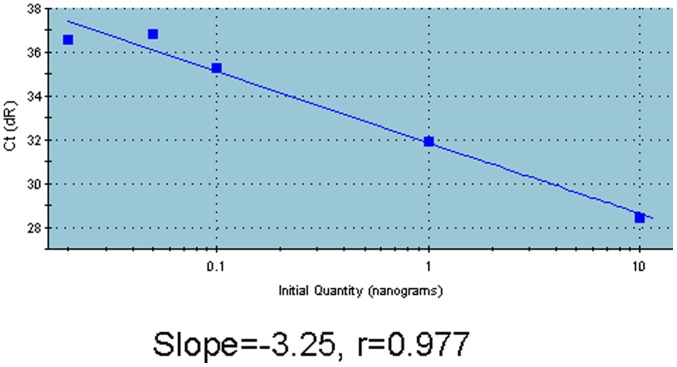
Quantification of KRAS mutant DNA.Varying amounts of KRAS mutant DNA were plotted against Ct values (threshold cycle). Slope, r value and regression line are shown.